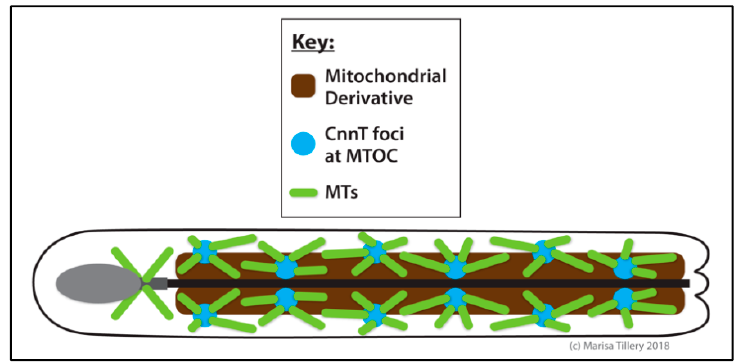
Figure 15. A splice variant of Cnn assembles ncMTOCs on the surface of spermatid mitochondria. During spermatid differentiation and elongation, CnnT localizes to mitochondrial derivatives, recruits γ -TuRCs, and converts mitochondria to ncMTOCs.